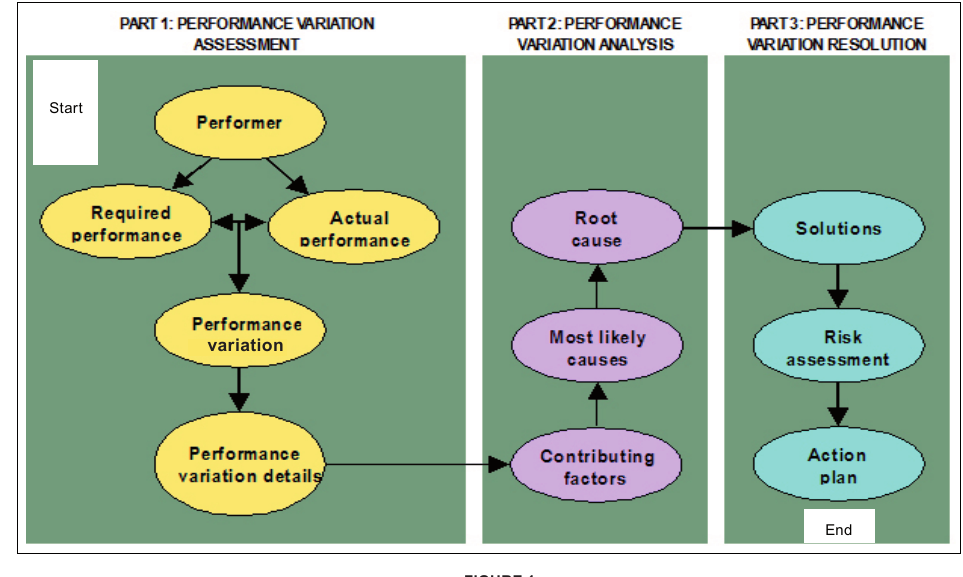
figurE 1 The Human Performance Variation Analysis (HPVA) process and steps (authors’